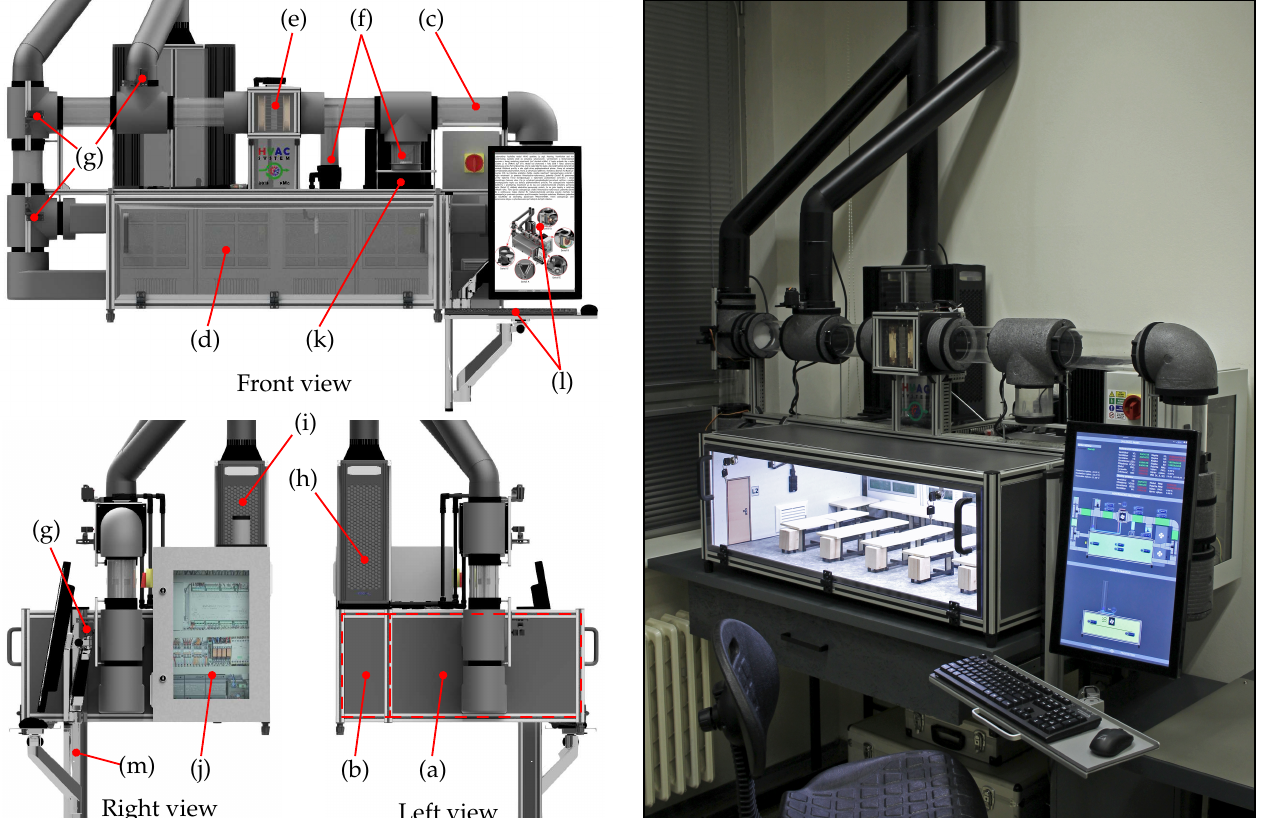
Figure 4. Laboratory HVAC system – CAD model in three views (left) and physical model (right). (a) – room-1 , (b) – room-2 , (c) – air duct, (d) – opening door, (e) – heating-cooling unit, (f) – humidifier with reservoir, (g) – servomechanisms, (h) – cooler for HCU-1 , (i) – cooler for HCU-2 , (j) – electrical distribution box, (k) – computer, (l) – HMI with PC peripherals, (m) – holder.